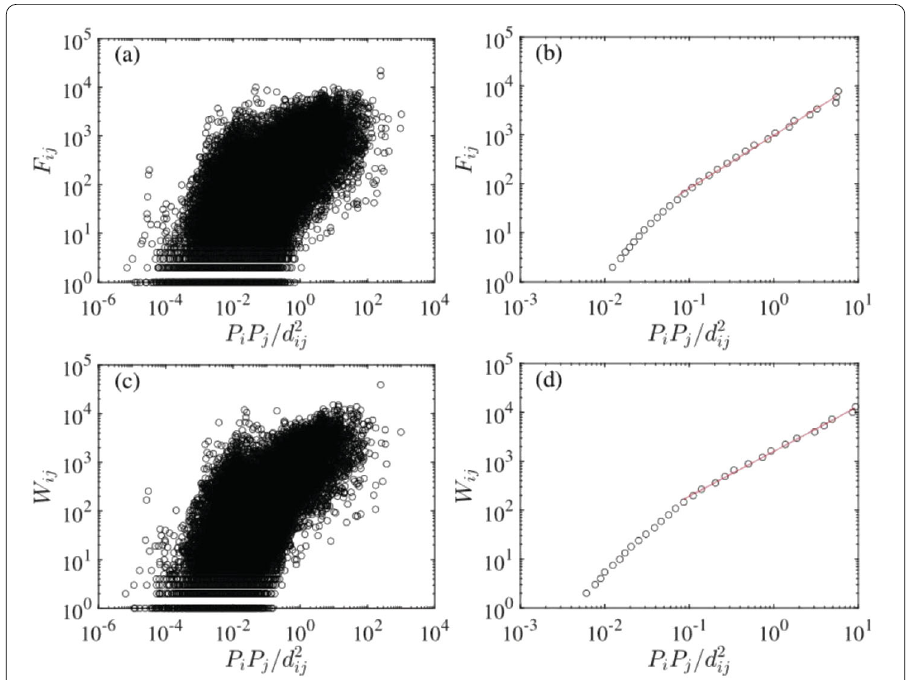
Figure 4 Testing the traditional gravity law with population for the directed and undirected freight highway transportation networks constructed over five months. ( a ) Scatter plot of F ij with respect to P i P j / d 2 directed network. ( b ) Binning plot of F ij with respect to P i P j / d 2 ij for the directed network. ( c ) Scatter plot of W ij with respect to P i P j / d 2 ij for the undirected network. ( d ) Binning plot of W ij with respect to P i P j / d 2 ij for the undirected